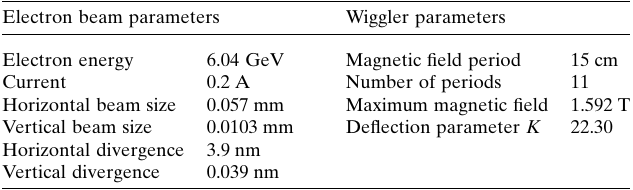
Table 1 ESRF electron beam parameters and ID17 wiggler parameters.